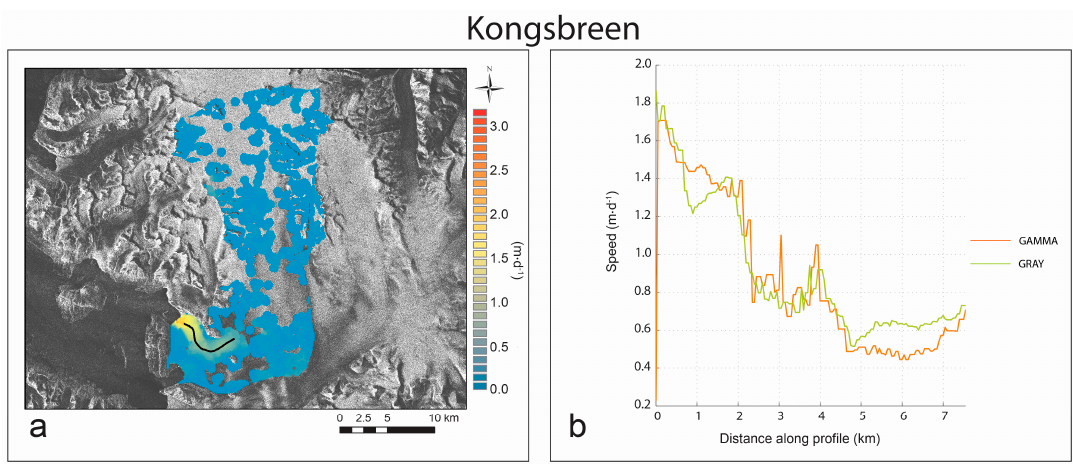
Figure 6. ( a ) Surface speed of the Kongsbreen (#2 in Figure 3) in NW-Spitsbergen (1–25 January 2013; WF; GRAY); and ( b ) speed profile along the centerline of Kongsbreen (orange: GAMMA; green: GRAY).